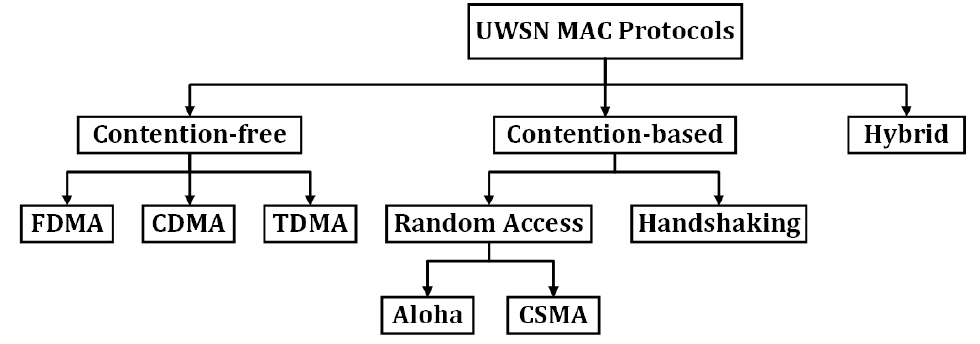
Figure 1. Classification of MAC Protocol Approaches [34] @ 2021